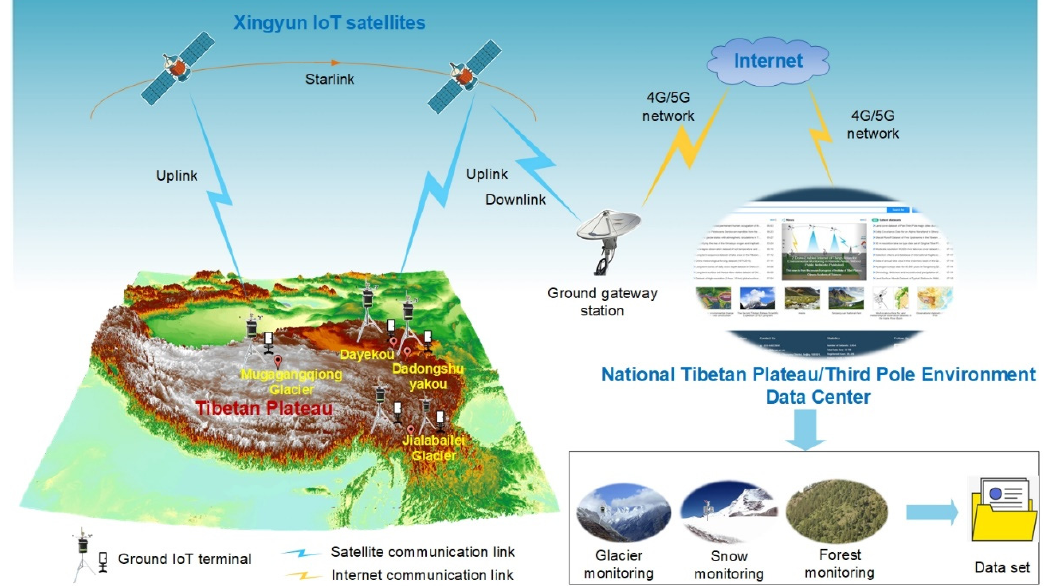
Figure 1. Implementation architecture of the Xingyun satellite-enabled Internet of Remote Things network for data retrieval from the Tibetan Plateau (TP). Five satellite-enabled ground IoT terminal devices are installed in the far-most areas of the TP, i.e., the Mugagangqiong glacier area, Jialabalei glacier area, Dadongshuyakou snow-covered area, and Dayekou forest. These devices monitor the local environment and upload remotely sensed data to IoT satellites during overpass. The satellites then transmit the uploaded data to the TP scientific data center via a gateway station and the Inter- net. The scientific data center finally publishes a monitoring dataset on an open-access web plat- form.